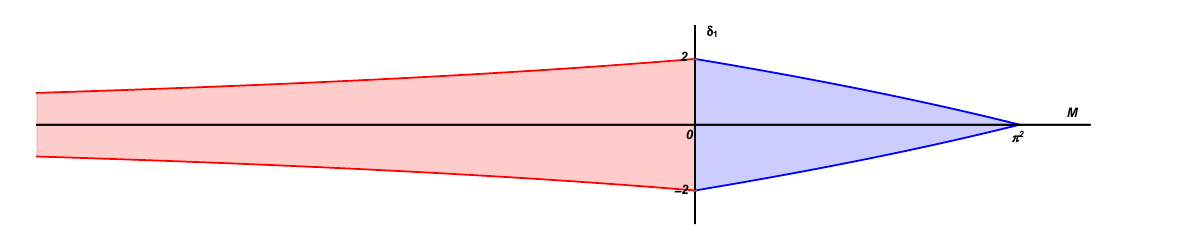
Figure 2. The blue and red areas represent the regions of the positive and negative sign of Green’s function,